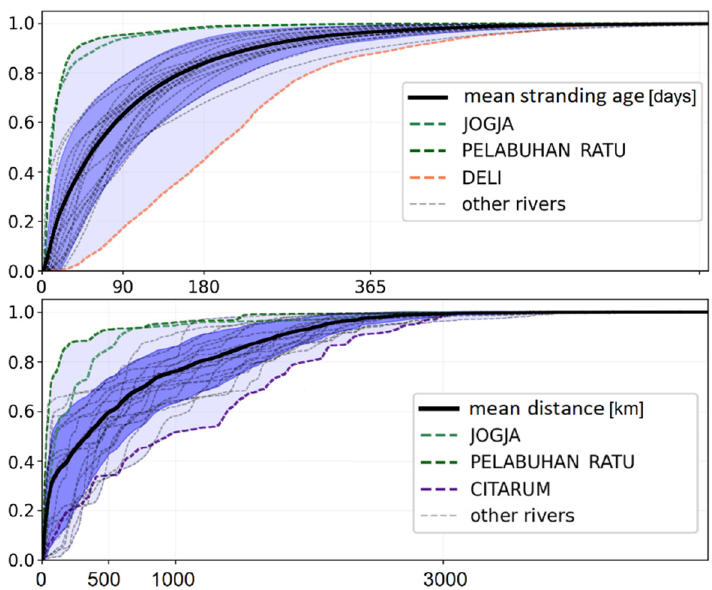
Figure 7. Upper panel: normalized cumulative sum of stranding ages for particles released from 21 Indonesian rivers. Bottom panel: normalized cumulative sum of the distances between particles’ initial locations and stranding locations. For both panels, the thick black line represents the normal- ized cumulative sum for all stranded particles, regardless of the riverine origin. The dashed lines correspond to normalized cumulative sums of stranded particles originating from a given riverine source. The extreme patterns displayed by the Jogja, Pelabuhan Ratu, Deli and Citarum rivers are highlighted with colored dashed lines. The dark purple shading corresponds to the standard deviation with respect to the riverine source. The light purple shading highlights the minimum and maximum